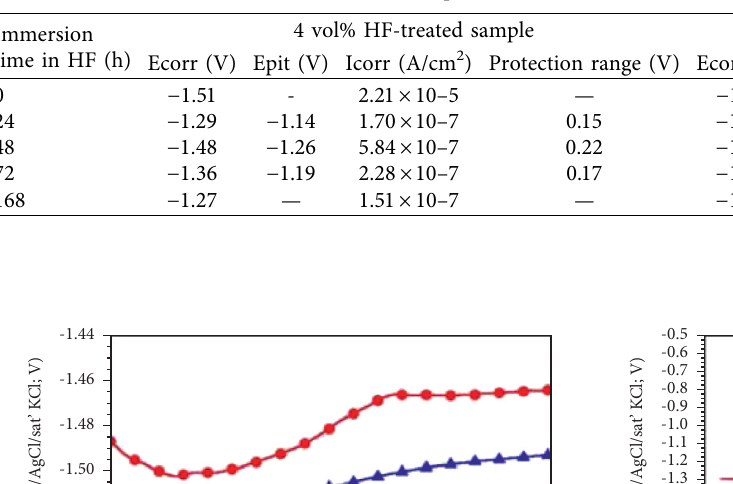
Table 3: Electrochemical parameters obtained from the anodic polarization curves [31].